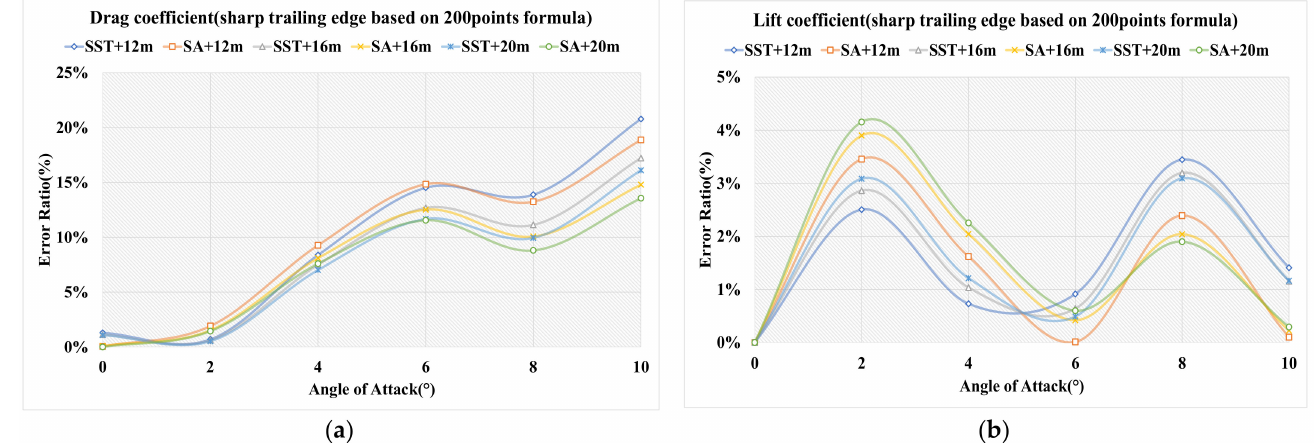
Figure 9. ( a ) Drag coefficient of sharp trailing edge based on 200 points formula; ( b ) lift coefficient of sharp trailing edge based on 200 points formula.